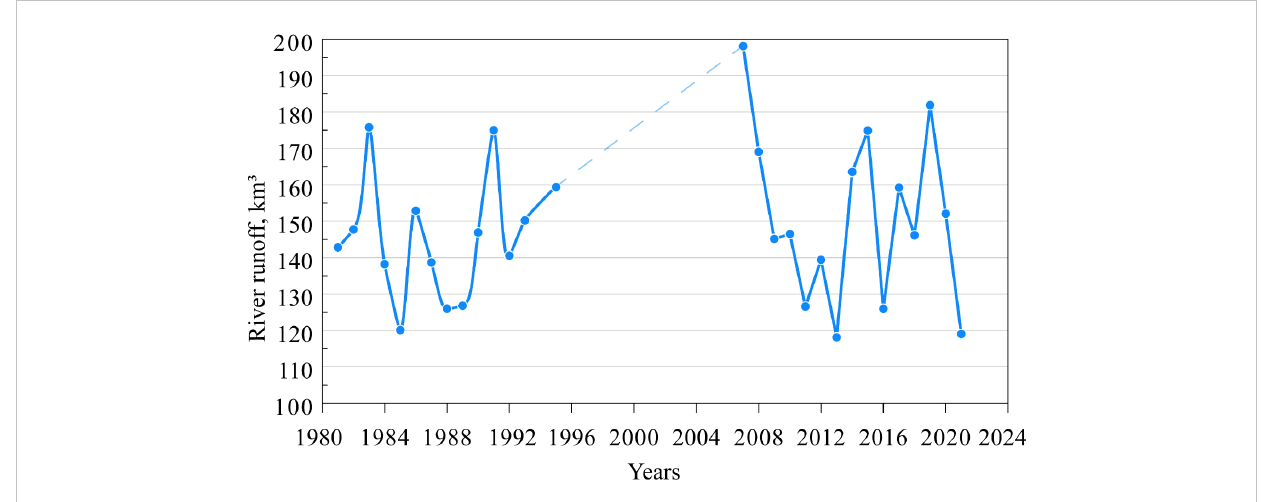
FIGURE 2 Inter-annual variability of the Pechora River runoff in 1981-1995 and 2006-2021.